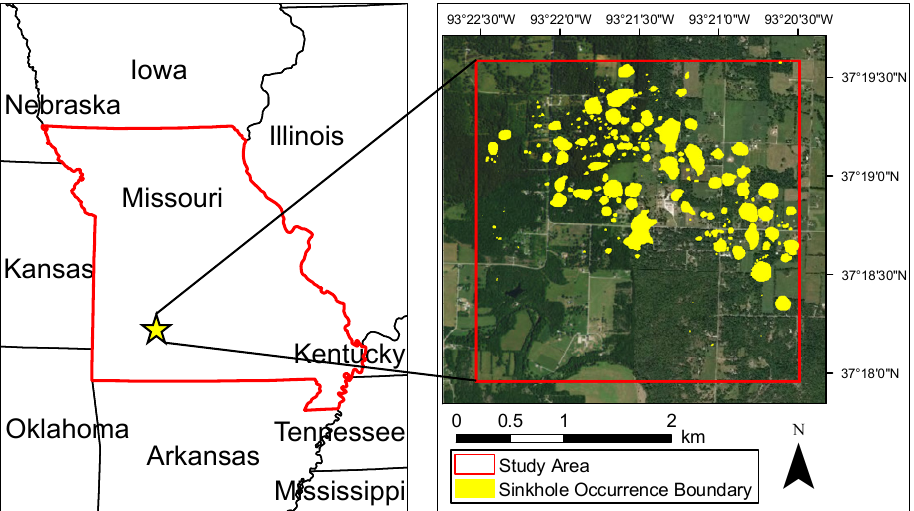
Figure 1. Location of study area and sinkhole occurrence boundary (Missouri, USA).